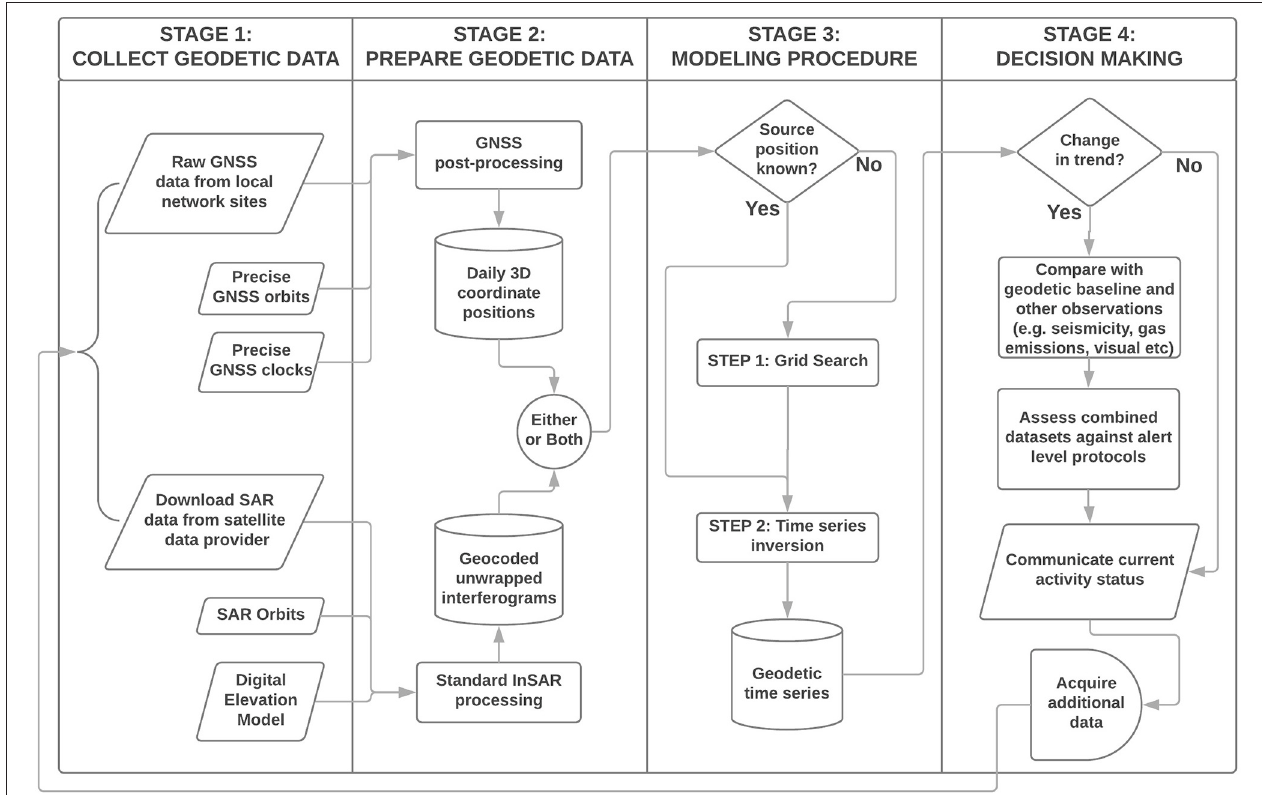
FIGURE 1 | Flow chart summarizing the four stage process to incorporate geodetic (InSAR and/or GNSS) data into the operational volcano monitoring work flow.